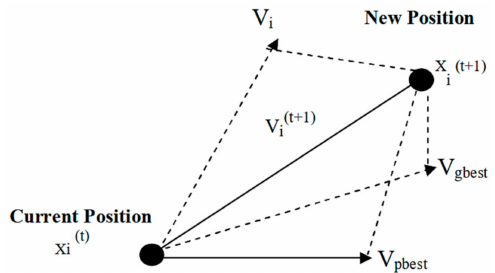
Figure 5. Change of position of PSO